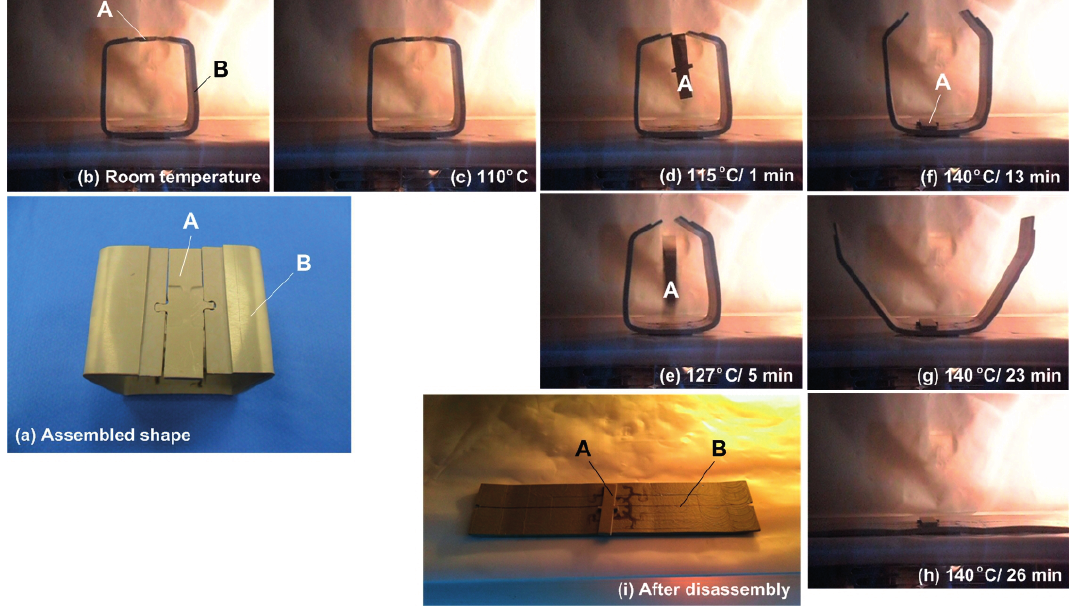
Figure 21. Programmed active disassembly of ABS/PC (used for Nokia NK-E51) box . ( a ) Assembled box ; ( b – h ) upon gradual heating to different temperatures for a certain period of time; and ( i ) fully disassembled components A and B.